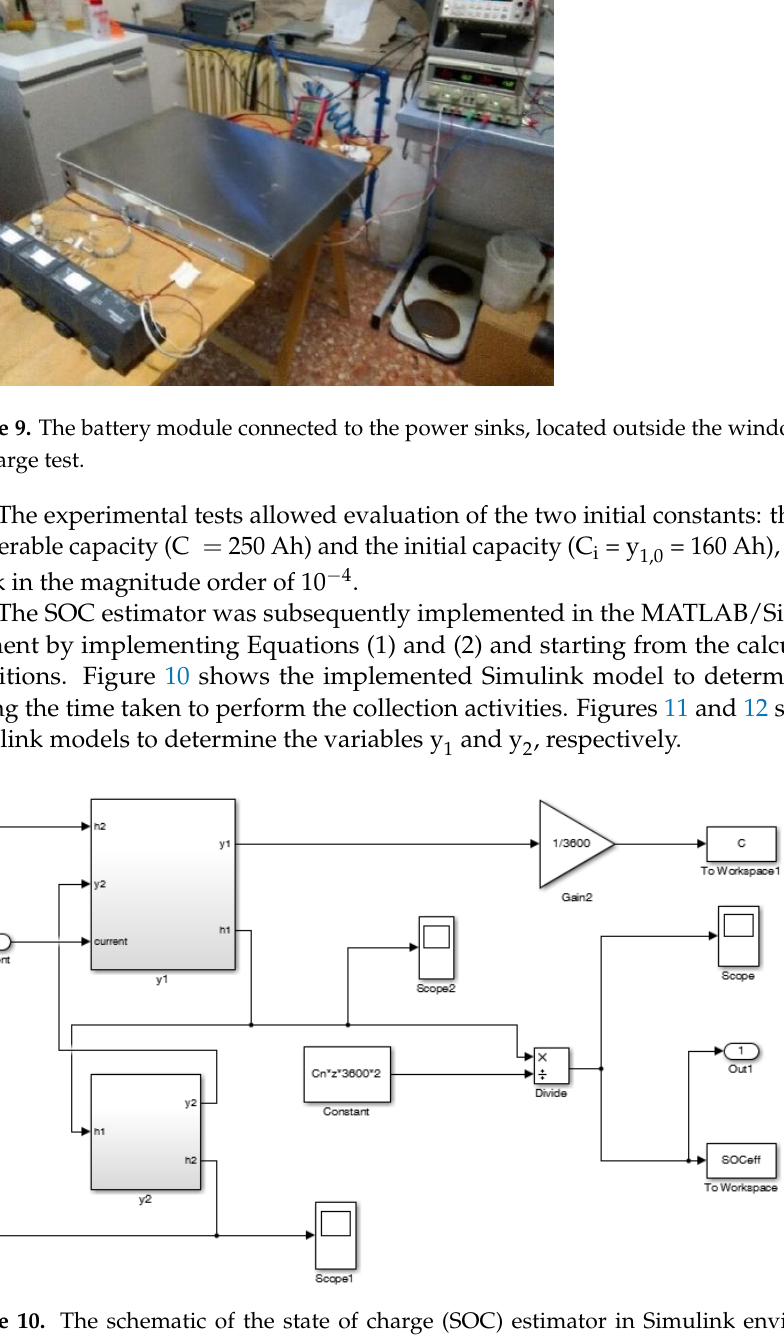
Figure 11. Simulink function to determine the variable 𝑦 1 in the kinetic battery model (KiBaM) modeling.